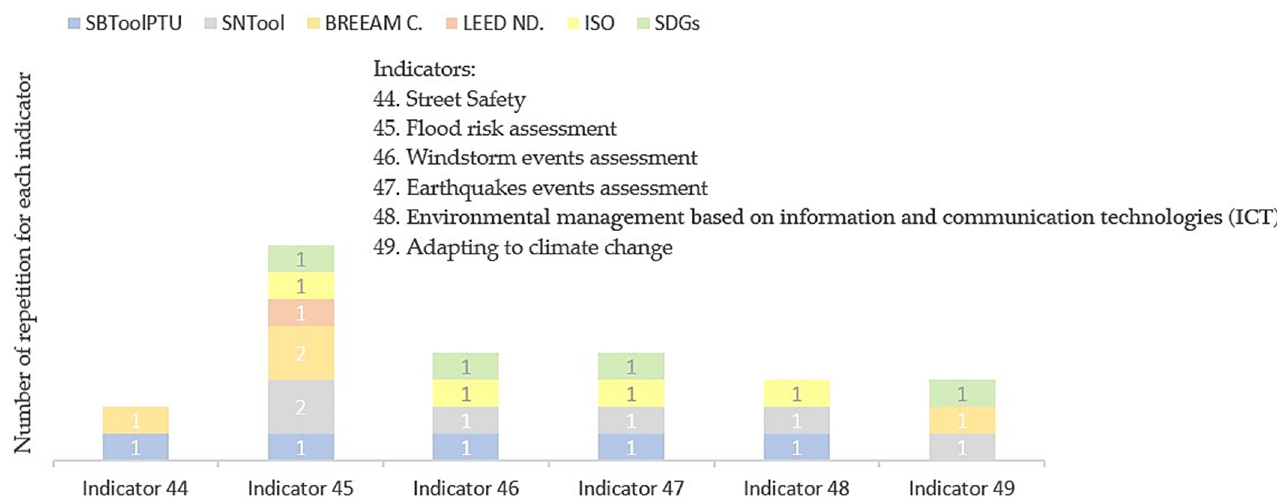
Figure 12. Frequency distribution of each indicator, relevant to the category of context and vulner- abilities in SBTool PT _Urban (2018), SNTool Min (2020), BREEAM-C (2012), LEED-ND (2018), ISO 37120, and SDGs.